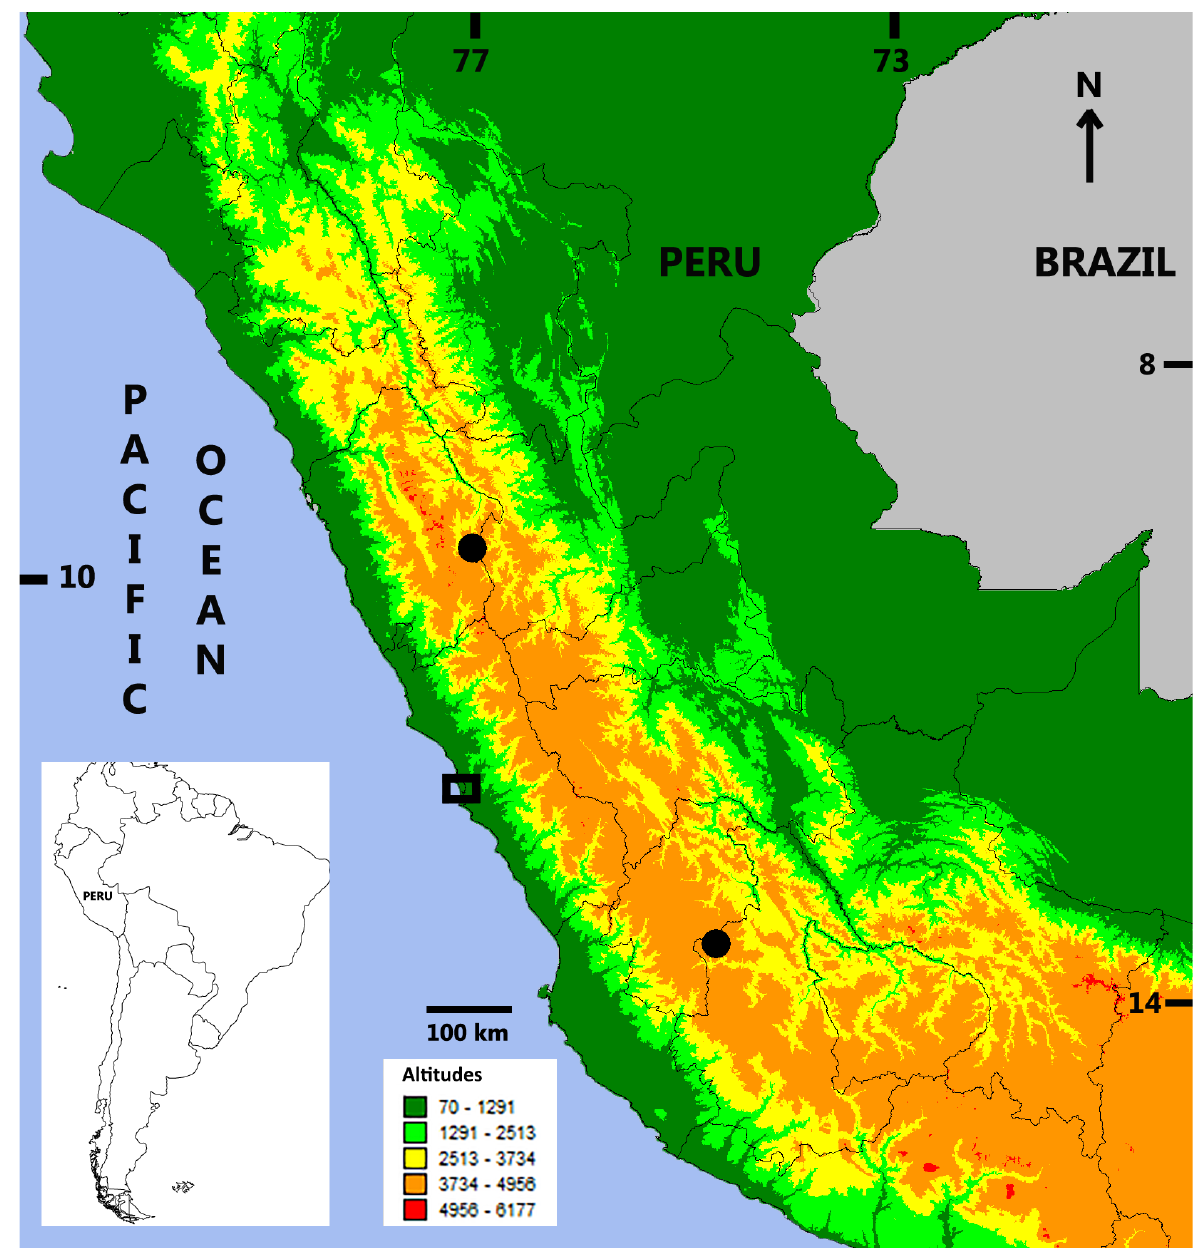
Figure 2. Geographic location of Pilularia americana sites (black circles) in Peru, and location of Lima, capital of Peru (hollow rectangle). Inset map of South America showing the location of Peru. In the main map, thin dark lines are departmental administrative units. Legend: altitude in meters, altitudinal ranges in color. Latitude and longitude in